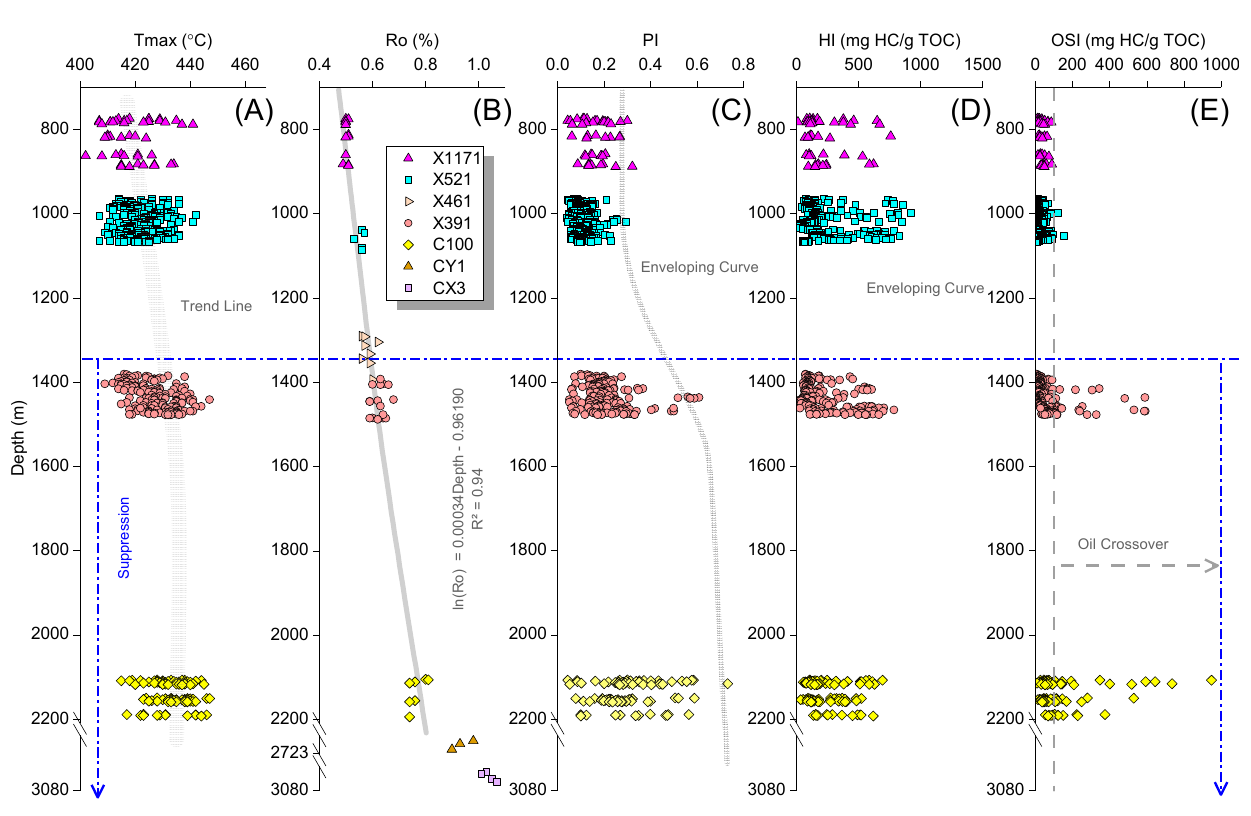
Figure 9. Geochemical profiles of wells with different buried depths. PI = S1/(S1 + S2); HI = S2/TOC × 100; OSI = S1/TOC × 100. ( A ) Tmax vs. depth plot shows that Tmax are suppressed below 1350 m. ( B ) Ro vs. depth plot shows that Ro increases with burial depth. ( C ) PI vs. depth plot, PI = S1/(S1 + S2). ( D ) HI vs. depth plot, HI = S2/TOC × 100. ( E ) OSI vs. depth plot showing obvious oil crossover effect below 1350 m, OSI = S1/TOC ×